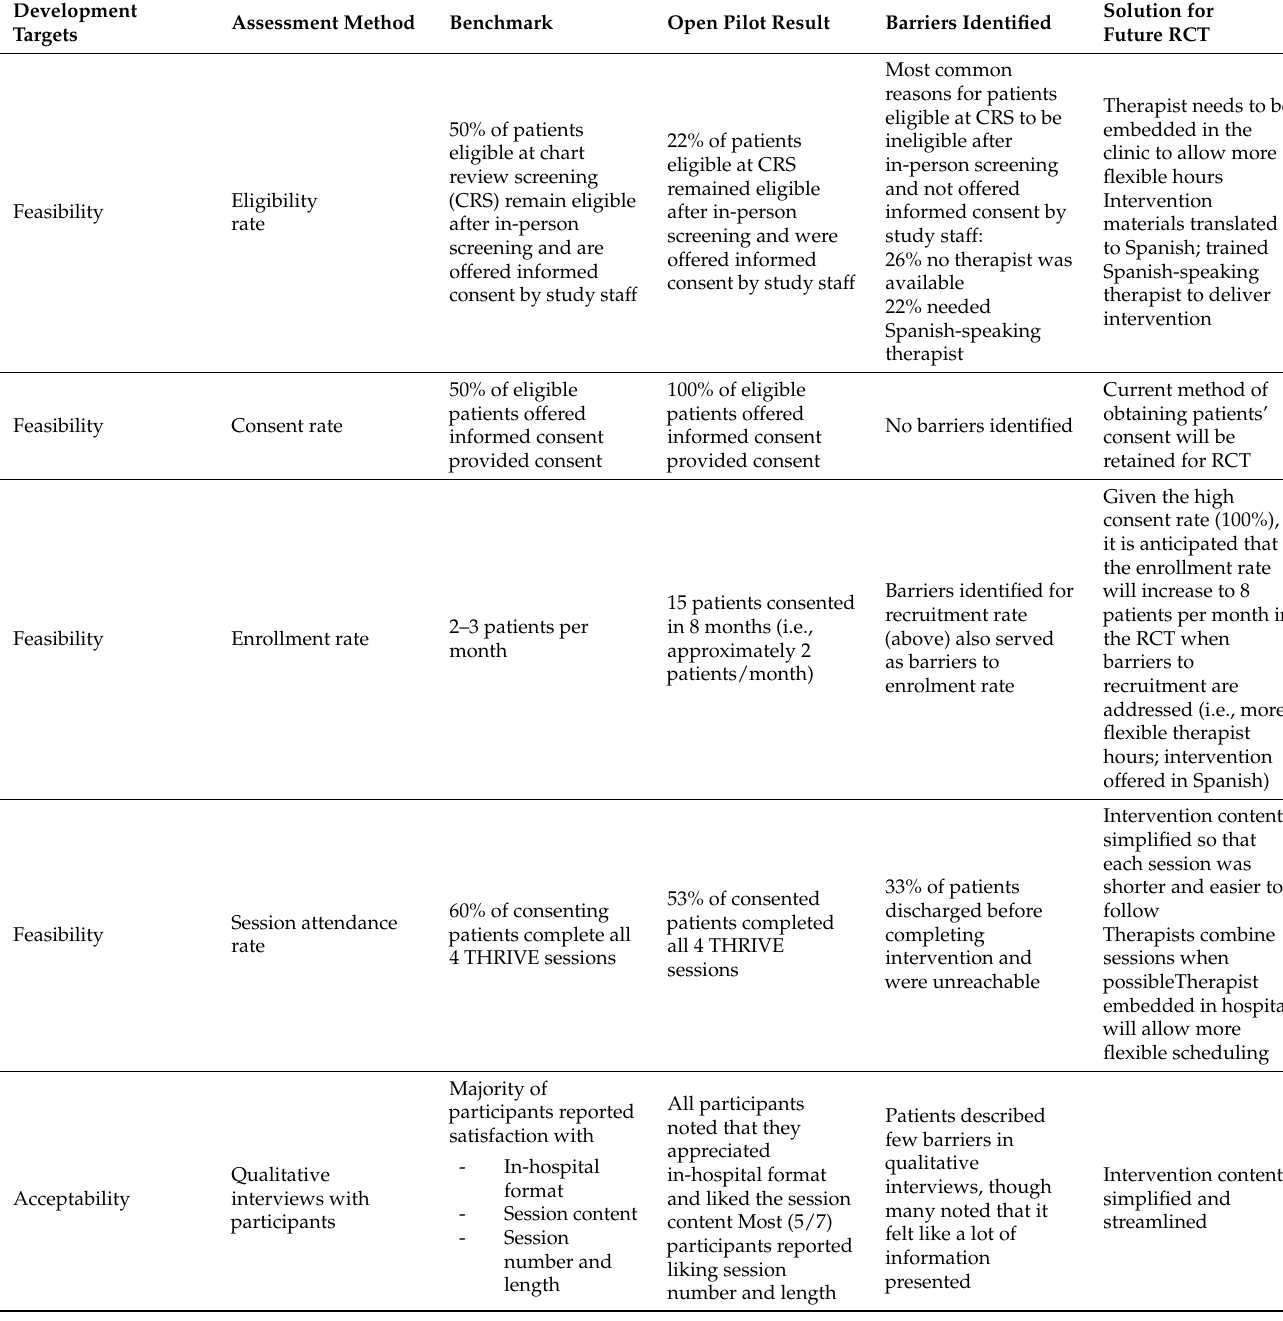
Table 2. Feasibility and acceptability of study